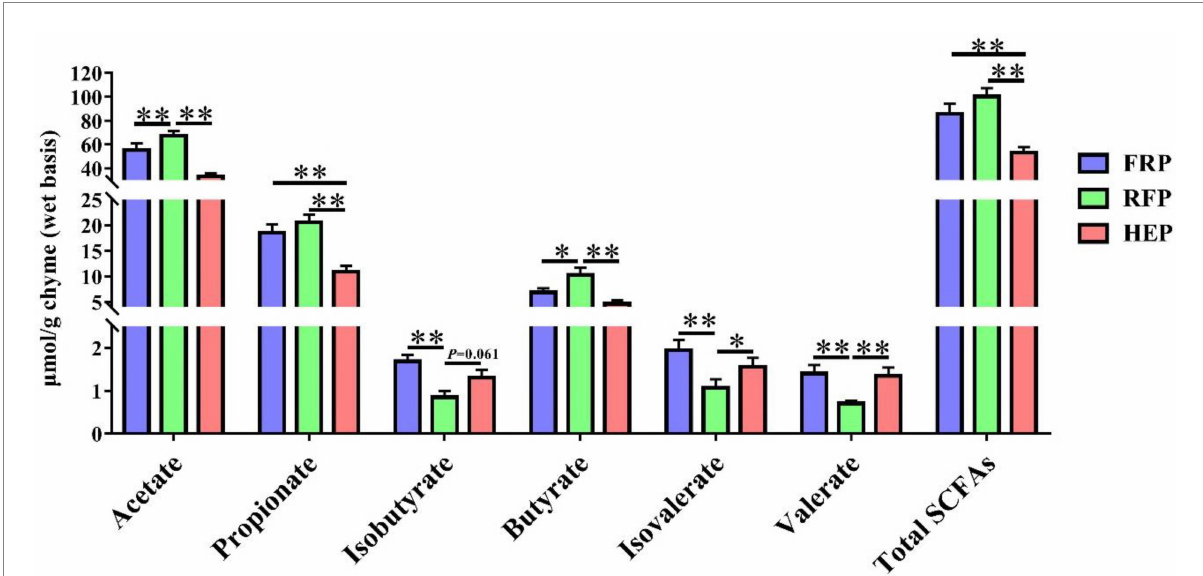
FIGURE 3 Effects of different feeding patterns on concentrations of short-chain fatty acid (SCFA), including acetate acid, propionic acid, isobutyric acid, butyric acid, isovaleric acid, valeric acid and total SCFAs in cecal chyme of Tibetan pigs. Data are expressed as mean ± SE ( n = 6–7). * and ** indicates p < 0.05 and p < 0.01, respectively. FRP: free-ranging Tibetan pigs; RFP: feeding the regular Tibetan pig diets; HEP: feeding the high energy content